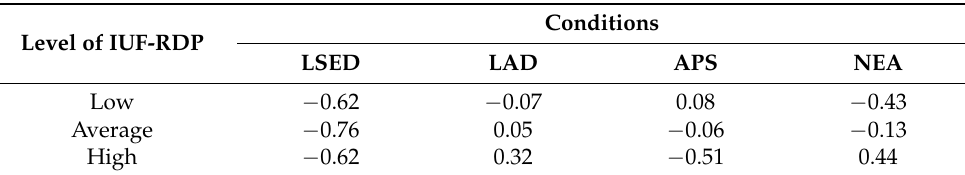
Table 4. Conditions for sustainable agricultural development against the level of use of proenviron- mental RDP funds. Source: own